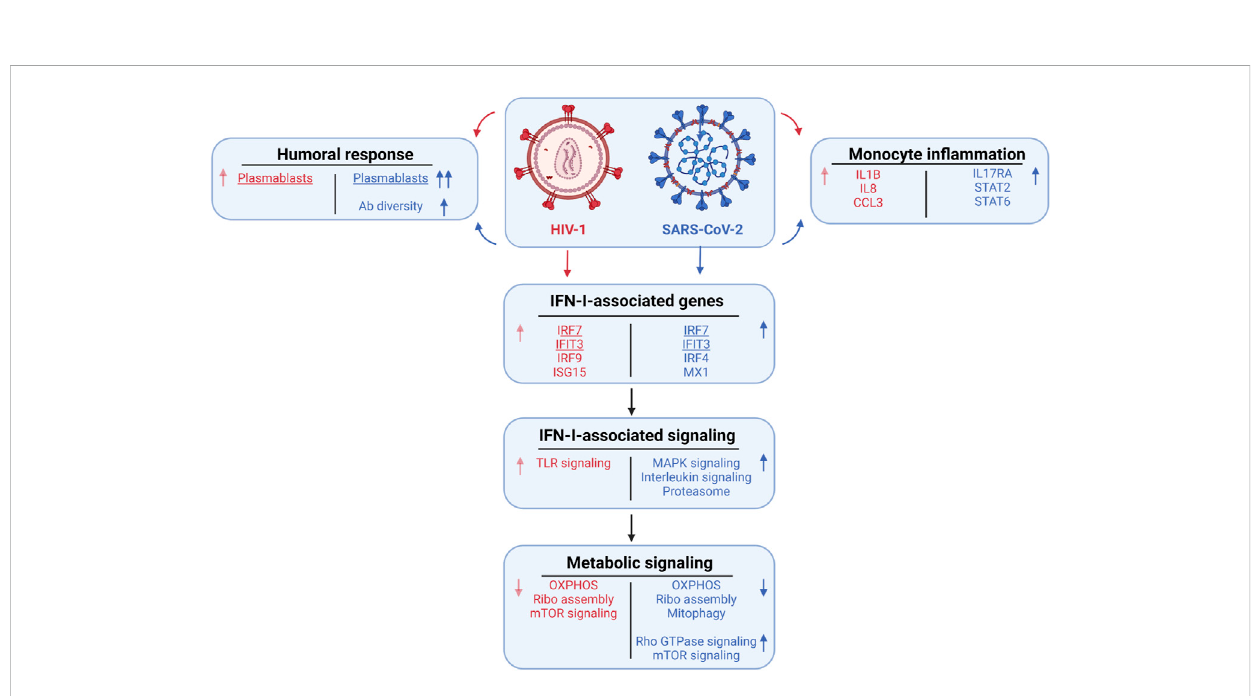
FIGURE 8 Summary of the major cellular shifts in COVID-19 compared to HIV-1.